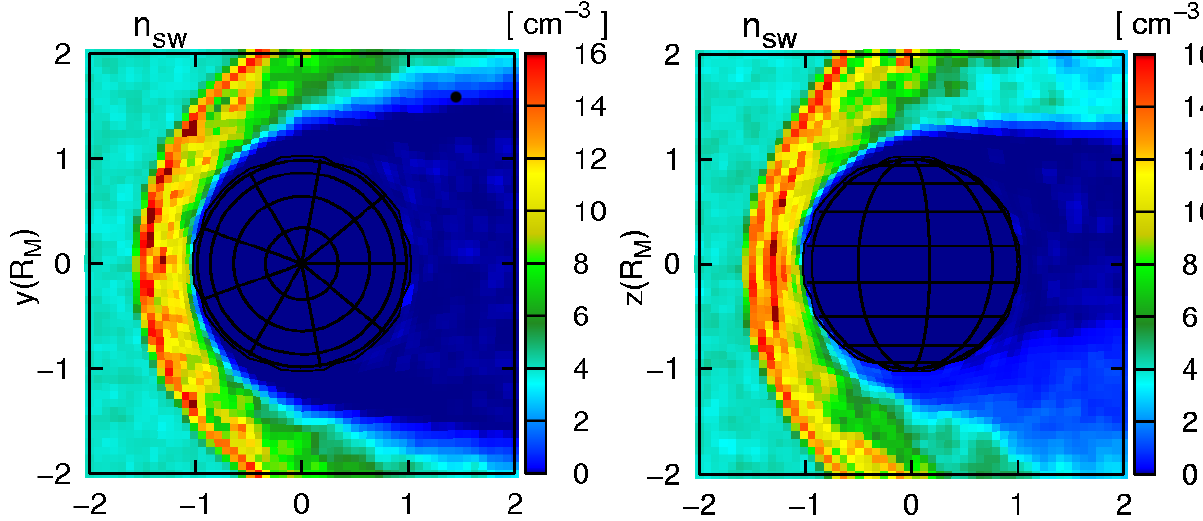
Fig. 5. Hybrid simulation: Distribution of the proton density in the xy plane (left) and xz plane (right).